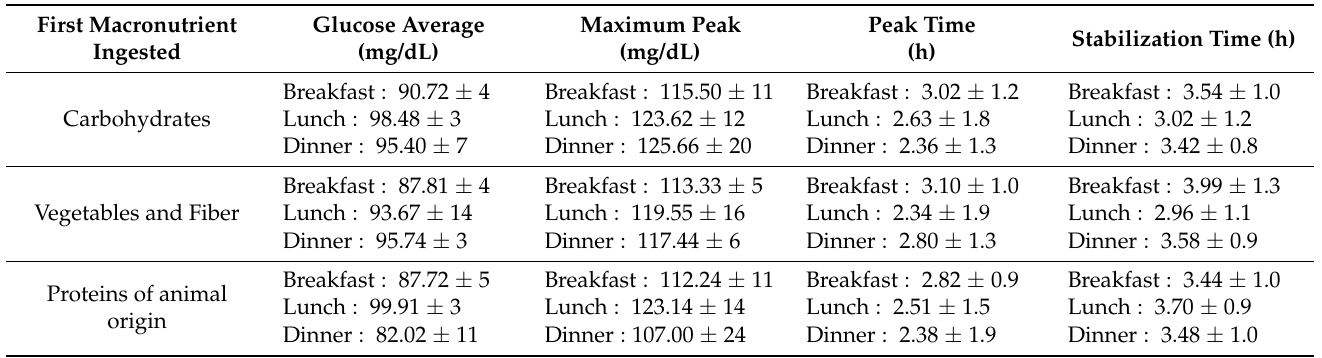
Table 6. Glycemic variation in relation to the first macronutrient ingested.